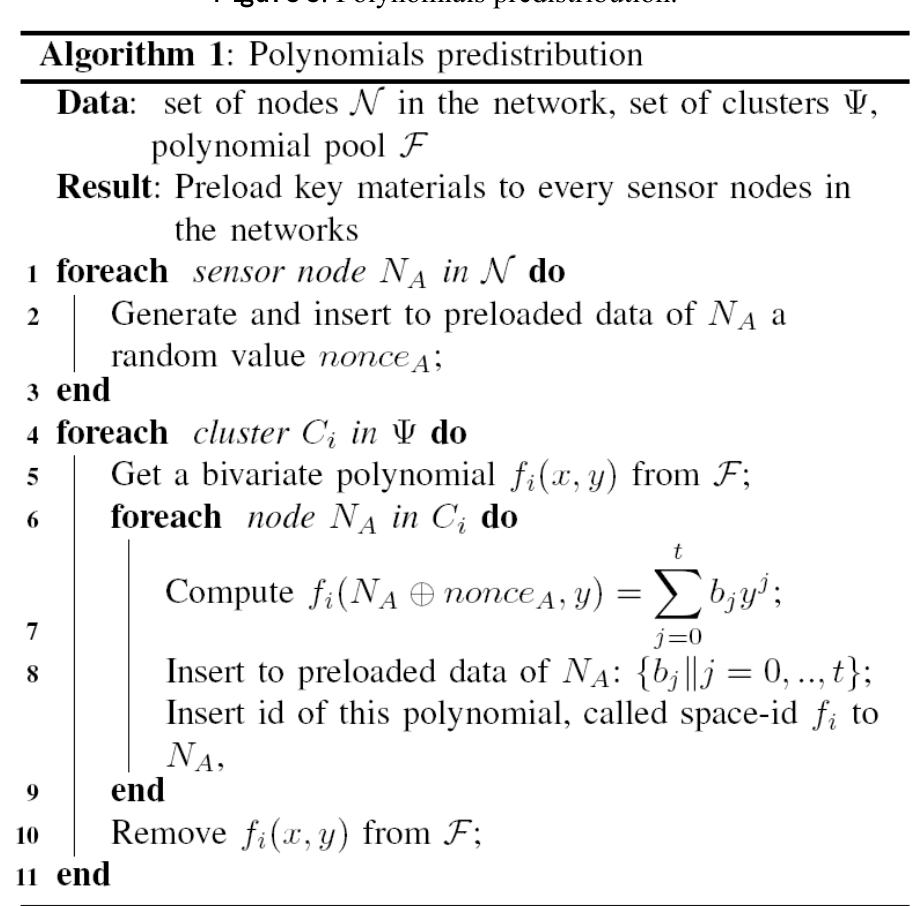
Figure 5 . Polynomials